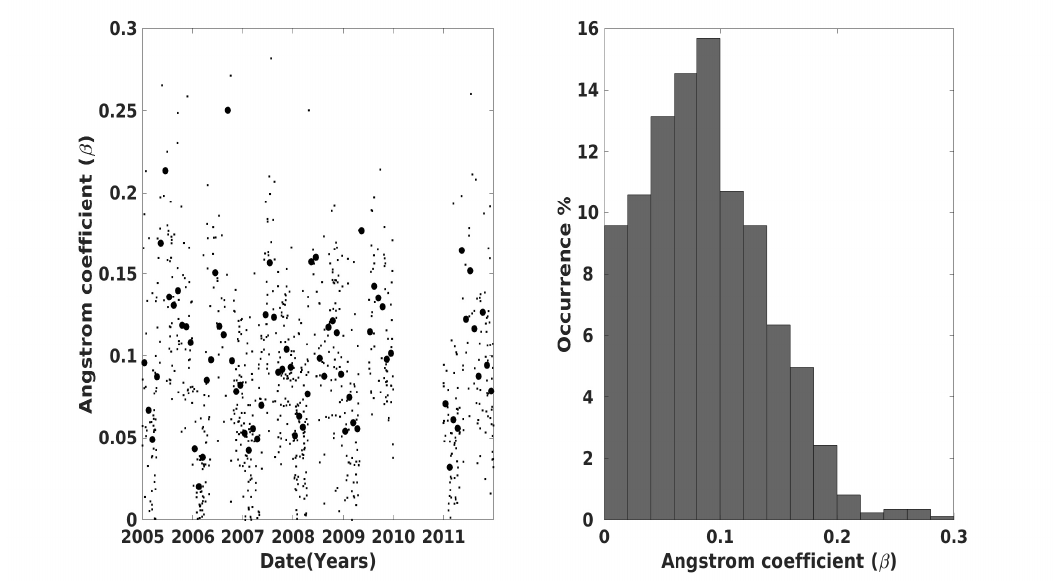
Figure 7. Left plot: daily variations of the Angström coefficient at Tamanrasset between 2005 and 2011. Right plot: Histogram of Angström coefficient